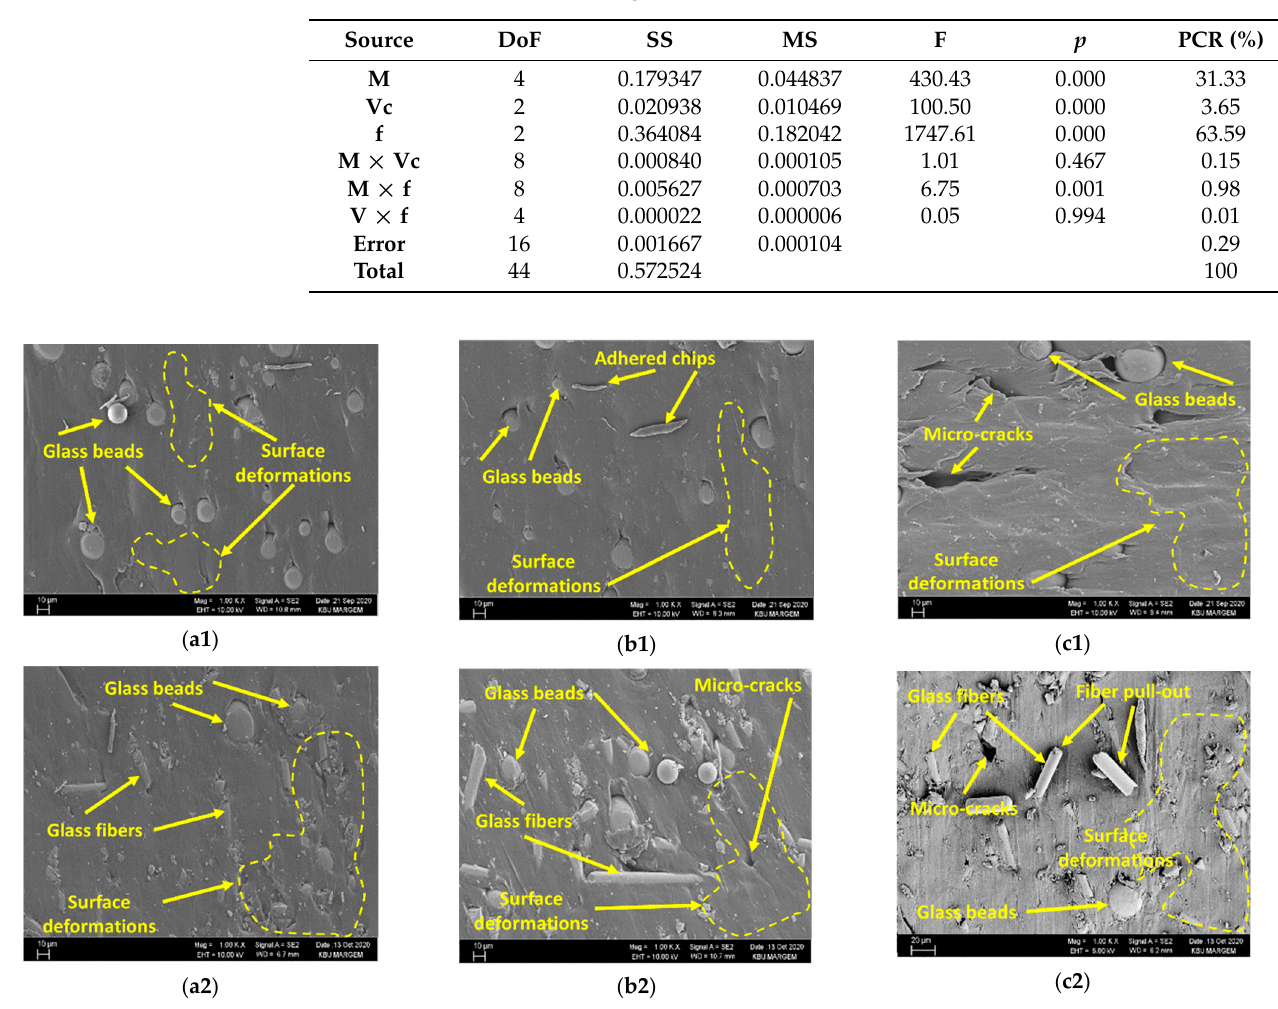
Table 4. ANOVA for surface roughness.